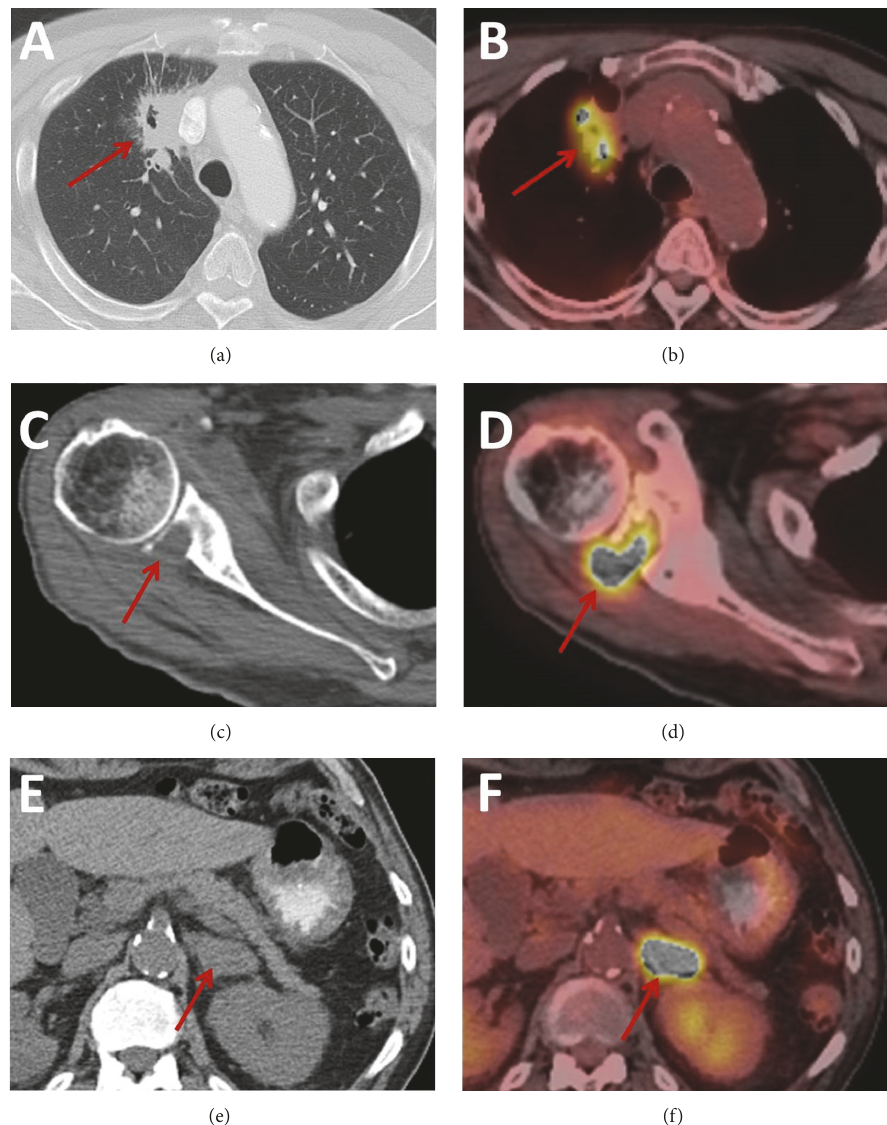
Figure 3: Axial noncontrast CT image in the lung window (a) demonstrates a spiculated mass with an area of central cavitation in the right upper lobe abutting the mediastinum (solid arrow) with imaging features suggesting a primary pulmonary squamous cell carcinoma. The corresponding PET/CT image (b) demonstrates hypermetabolic activity (solid arrow) within this lesion. Axial noncontrast CT image in the bone window (c) demonstrates a soft tissue lesion centered in the right subscapularis muscle with destruction of the adjacent bony glenoid (arrow). Corresponding PET/CT imaging (d) demonstrates hypermetabolic activity (solid arrow) within this lesion. Axial noncontrast CT image in the soft tissue window (e) demonstrates a solid lesion in the left adrenal gland (solid arrow) with the corresponding PET/CT image (f) demonstrating hypermetabolic activity (solid arrow) within this